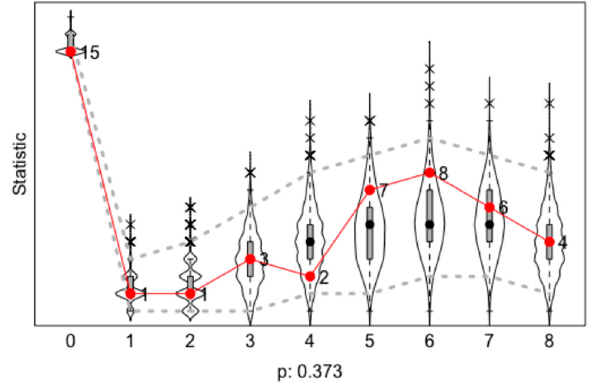
Figure 4. The result of model goodness-of-fit tests.